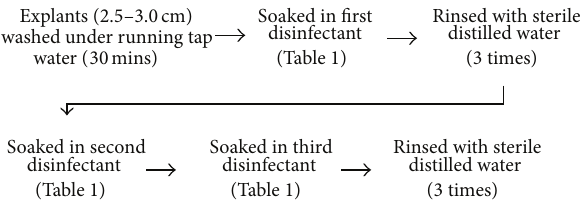
Figure 1: General sterilization method for shoot bud explants of Calathea crotalifera